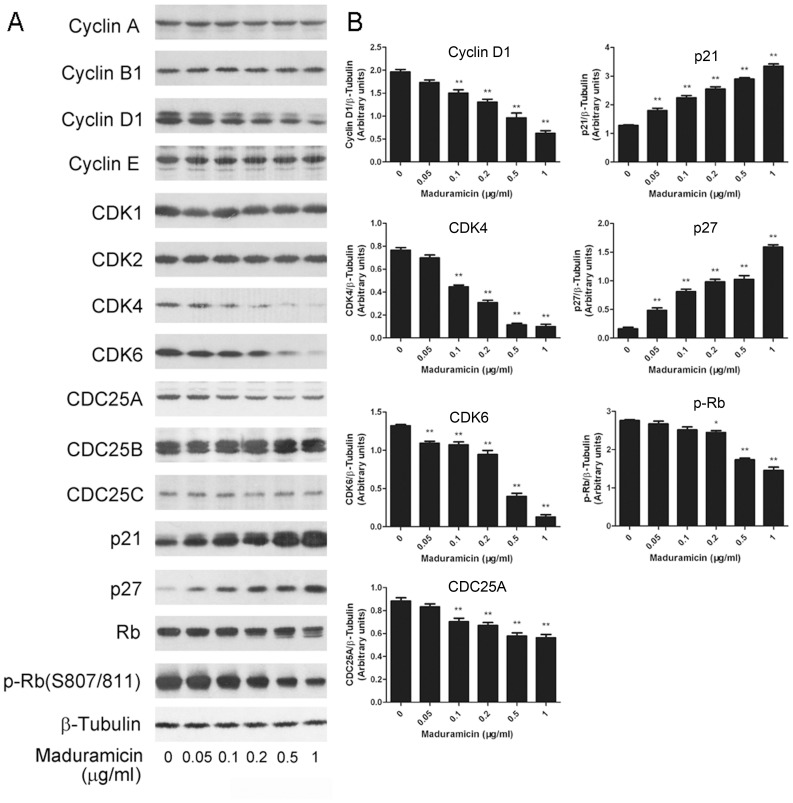
Maduramicin downregulates protein expression of cyclin D1, CDK4, CDK6, and CDC25A, and upregulates expression of p21Cip1 and p27Kip1, resulting in hypophosphorylation of Rb in C2C12 cells.C2C12 cells were treated with maduramicin for 24 h at indicated concentrations, followed by Western blotting with indicated antibodies. β-Tubulin was used for loading control. Representative blots are shown (A). Blots for indicated proteins were semi-quantified using NIH image J (B). Results are presented as means ± SE (n = 3, corresponding to three independent experiments). *P<0.05, **P<0.01, difference with the control group.